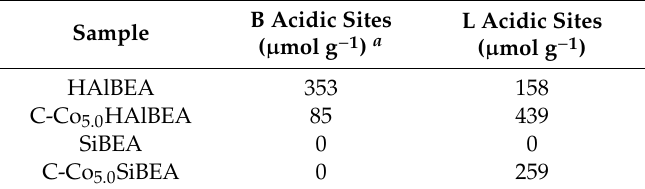
Table 4. Evolution of the B and L acidic sites concentration in C-Co 5.0 HAlBEA, HAlBEA, C-Co 5.0 SiBEA and SiBEA.